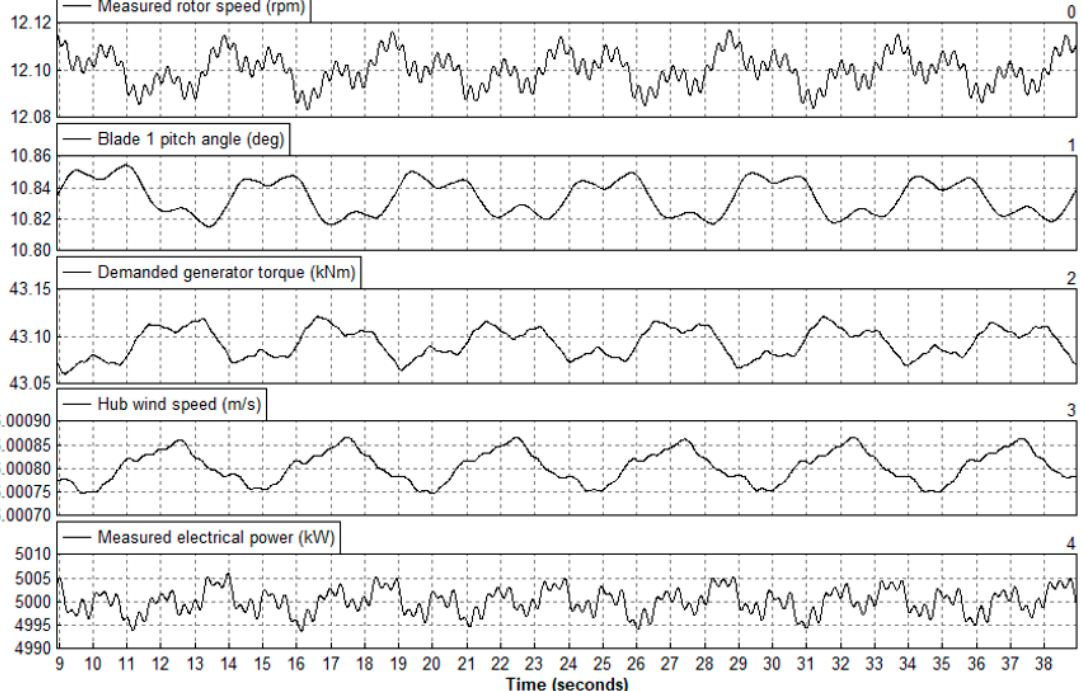
Figure 8. Error in blade’s pitch angle with a built-in controller.